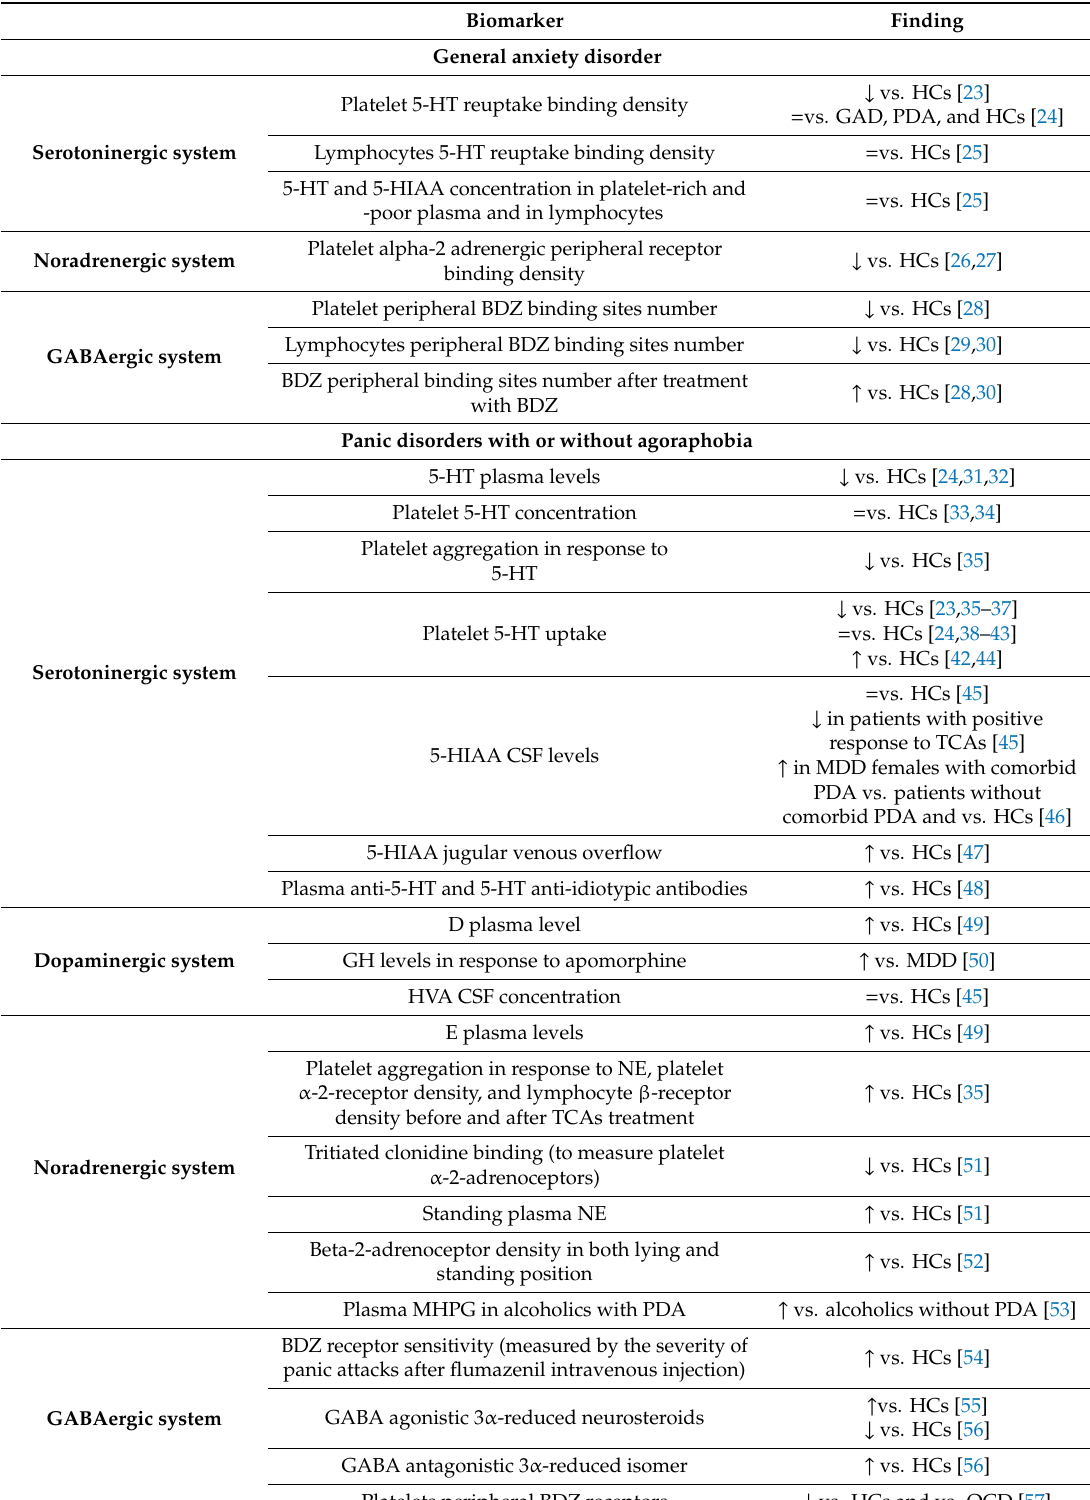
Table 1. Summary of the literature findings related to the neurotransmitters involved in general anxiety disorders (GAD), panic disorders with or without agoraphobia (PDA), and social anxiety disorder